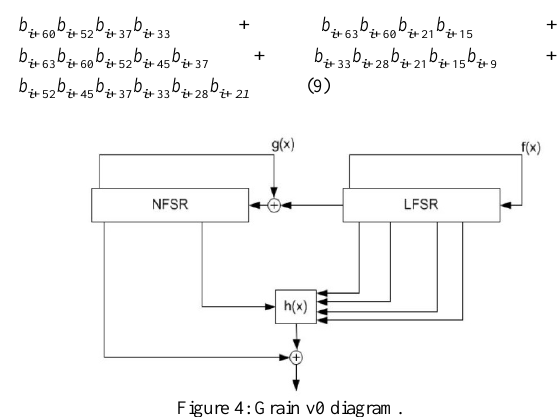
Figure 4: Grain v0 diagram. Figure 4 show diagram of both two shift registers represent state of the algorithm. Four (4) variables taken from LFSR and one (1)